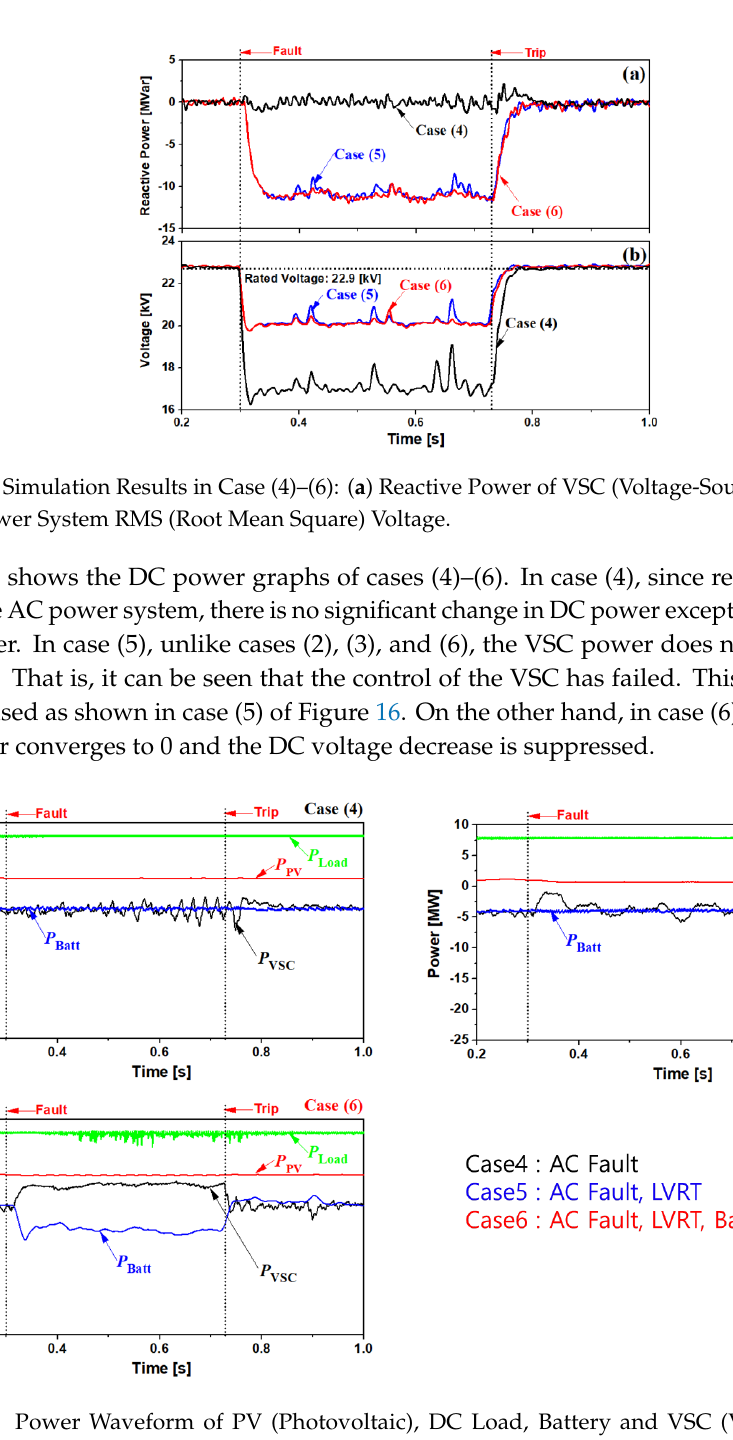
Figure 16. Simulation Results in Case (4)-(6): ( a ) Instantaneous Power of VSC (Voltage Sourced Converter); ( b ) DC Link Voltage. In the current study, we used SPWM (sinusoidal pulse width modulation) as a modulation method of VSC, and in this method, the AC side line-to-line voltage is 0.78 times that of the DC voltage. Therefore, there was no problem of controlling VSC in case (2) where the DC voltage increases, but in case (5) where the DC voltage decreases, there is a problem that the control of VSC is not properly performed. However, if the DC voltage reduction is suppressed through battery control, the same problem as case (5) can be solved.